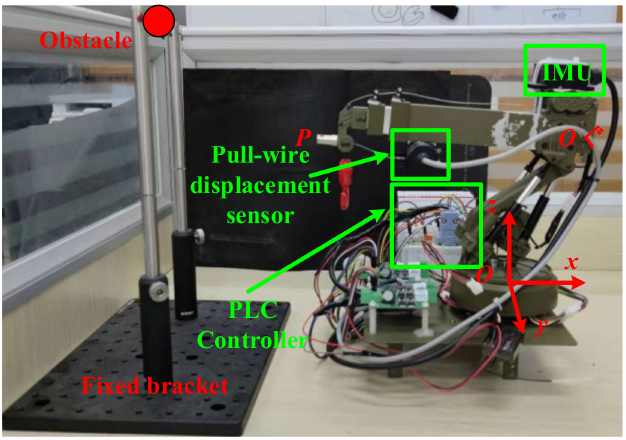
Figure 10. Semi-physical testing